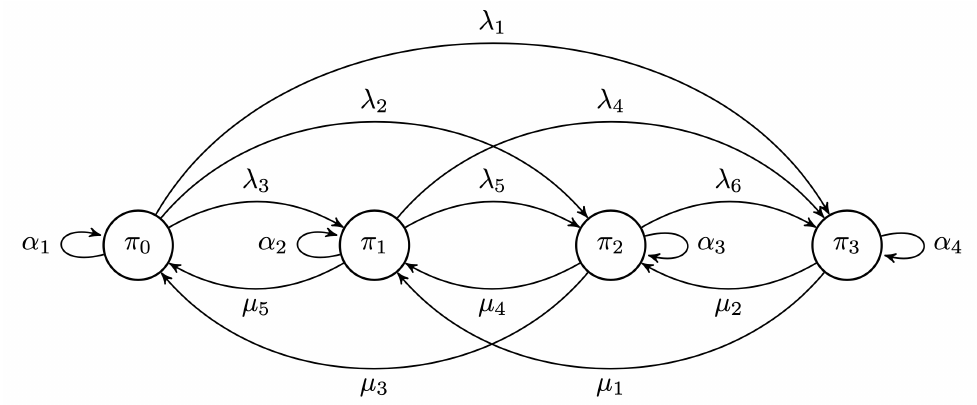
Figure 3. DTMC model of a node with four operational states. The state transitions ( α n , λ n , and µ n ) represent various reactions and responses to disruption